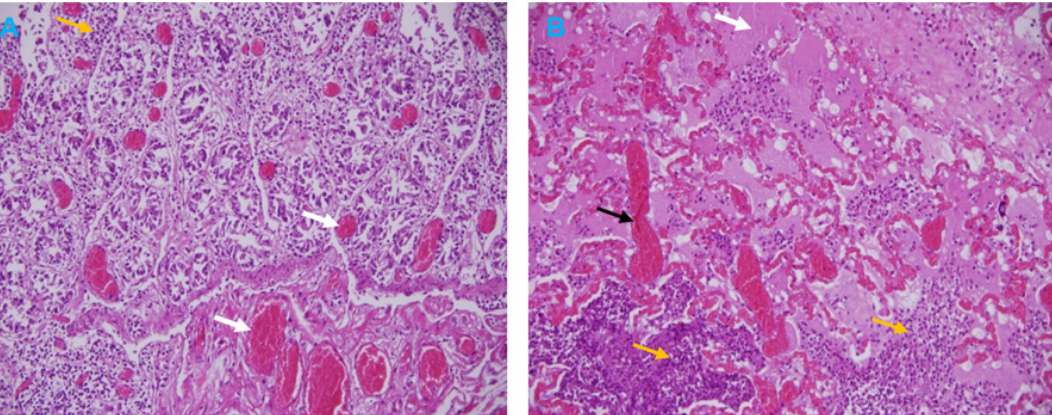
Figure 4. Microscopic lesions of PPR in a Goat. ( A ) Intestine section showing hemorrhagic enteritis with vascular changes (white arrows) and infiltration of inflammatory cells (yellow arrow). ( B ) Lung section showing acute hemorrhagic pneumonia with vascular changes including edema (white arrow), congestion (black arrow) and infiltration of inflammatory cells (yellow arrows). H&E stain, 20×.